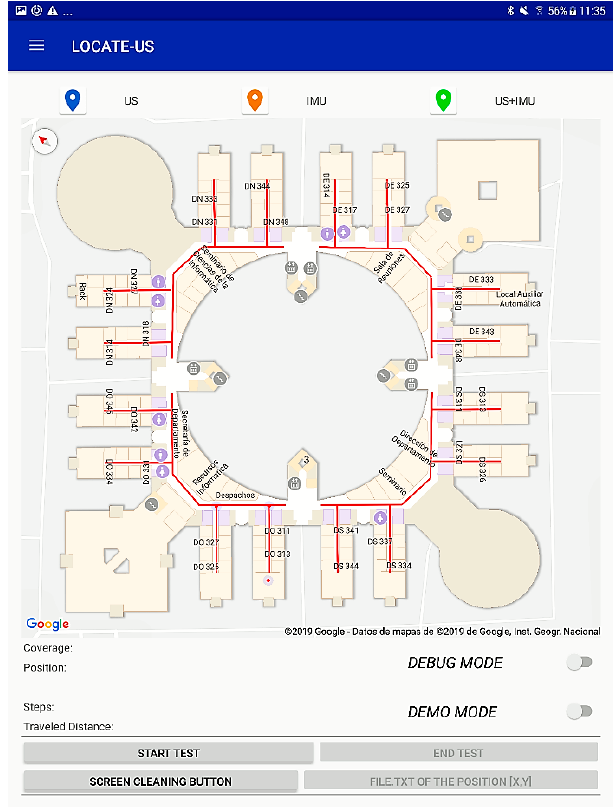
Figure 5. Graph considered in the LOCATE-US application for the corridors of the third floor from the School of Engineering in the University of